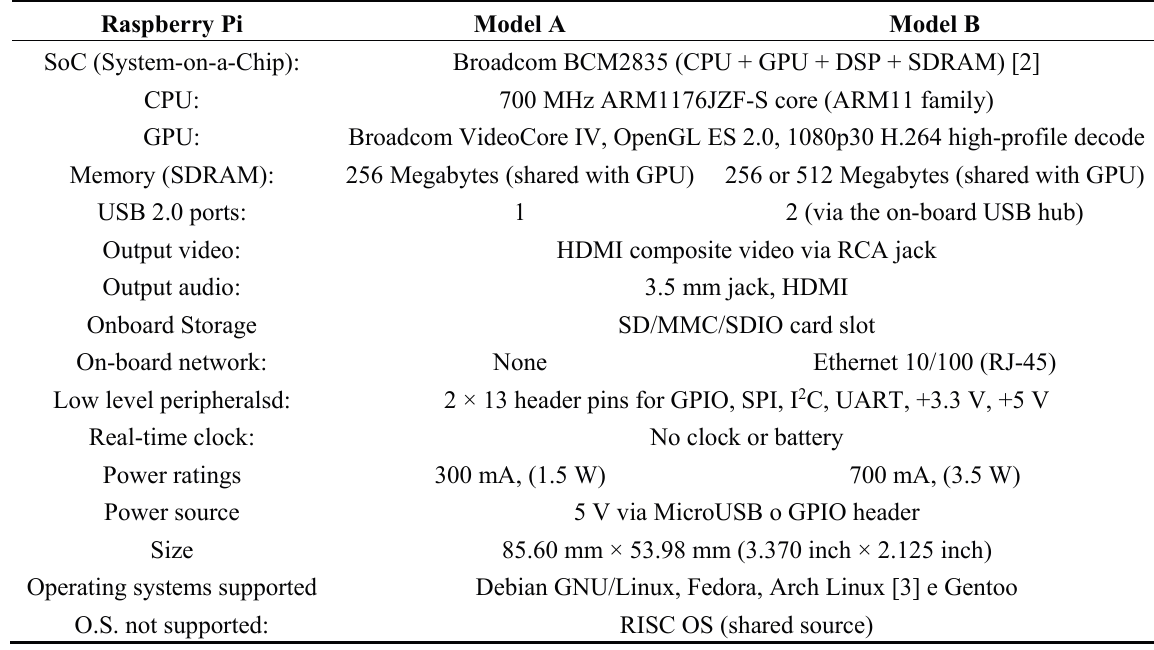
Figure 4. The Raspberry Pi computer. Table 1. Main characteristics of the Raspberry Pi